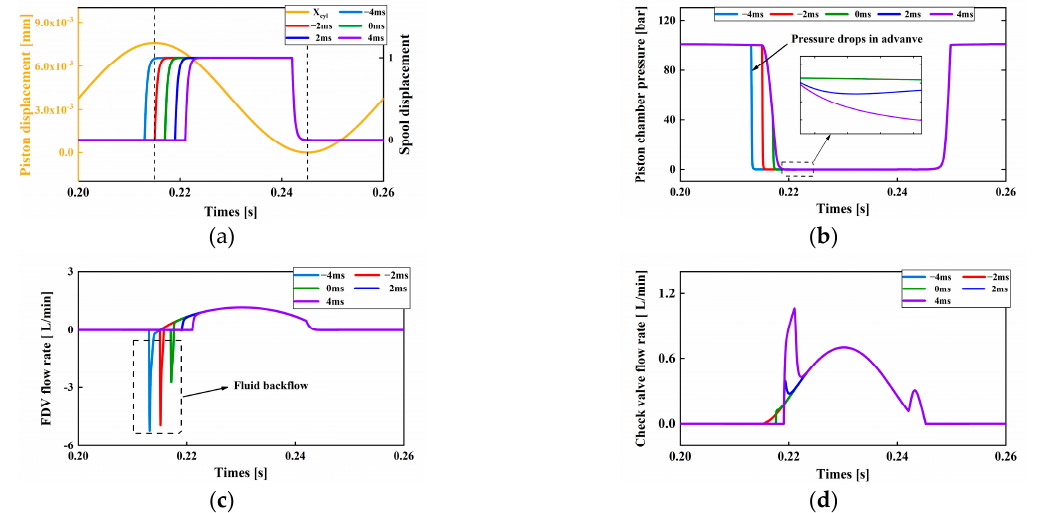
Figure 5. C haracteristics with different 𝑇 (cid:3042)(cid:3030) : ( a ) spool displacement; ( b ) piston chamber pressure; ( c ) Figure 5. Characteristics with different T oc : ( a ) spool displacement; ( b ) piston chamber pressure; FDV flow rate; ( d ) auxiliary check valve flow rate. ( c ) FDV flow rate; ( d ) auxiliary check valve flow